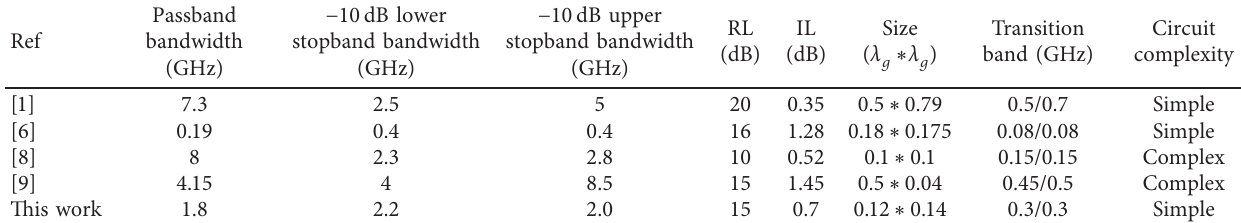
Table 1: Comparisons with some previous